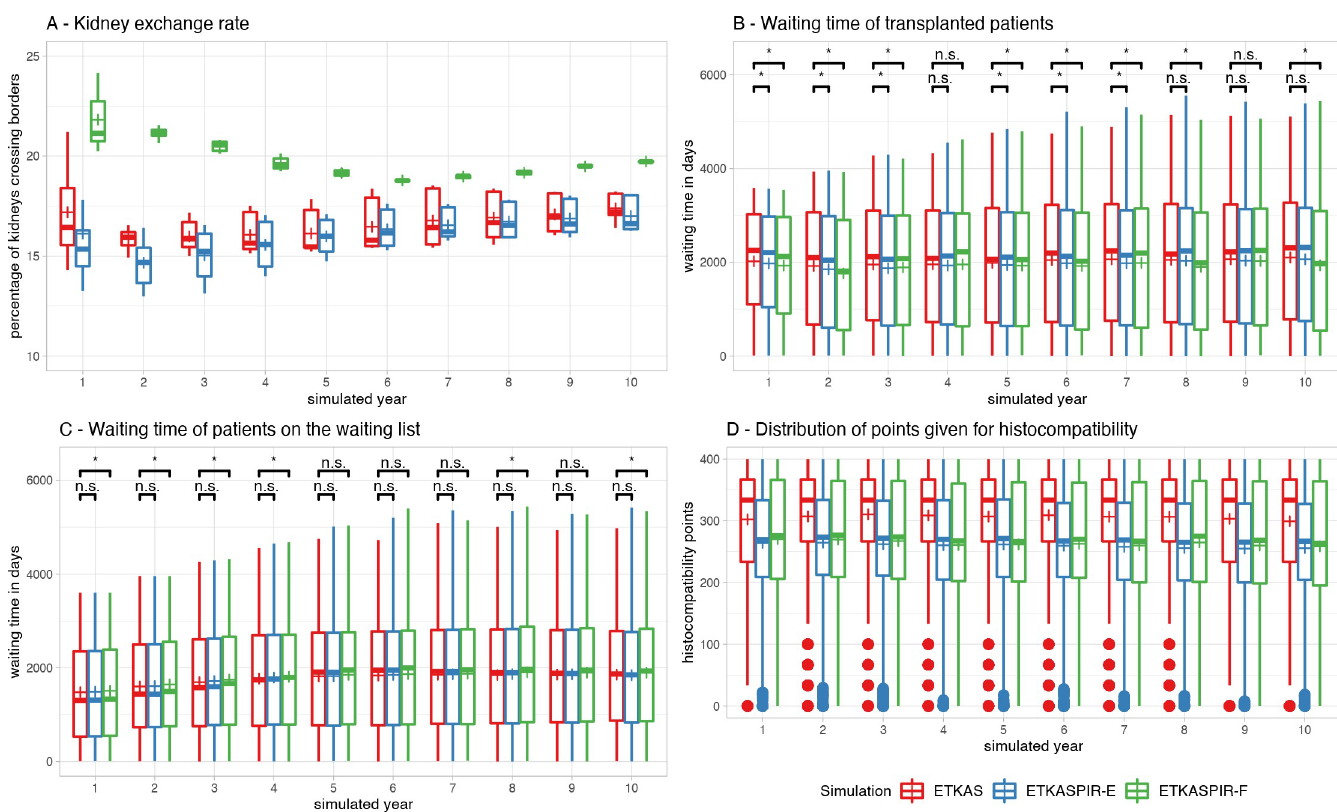
Fig 7. Monitoring metrics. (A) After the simulation stabilized, the amount of cross-border donor exchange remained similar between the simulated ETKAS and ETKASPIR-E. Outliers in the burn-in period were suppressed for readability. (B) Average waiting times of transplanted patients was slightly lower in ETKASPIR-E, (C) whereas average waiting times of patients on the waiting list increased mildly. (D) number of match points given by match compatibility in the different simulations. Boxplots depict the median (horizontal line), mean (plus) and first to third quartile (box), the highest and lowest value within 1.5x IQR (whiskers), outliers (circles).